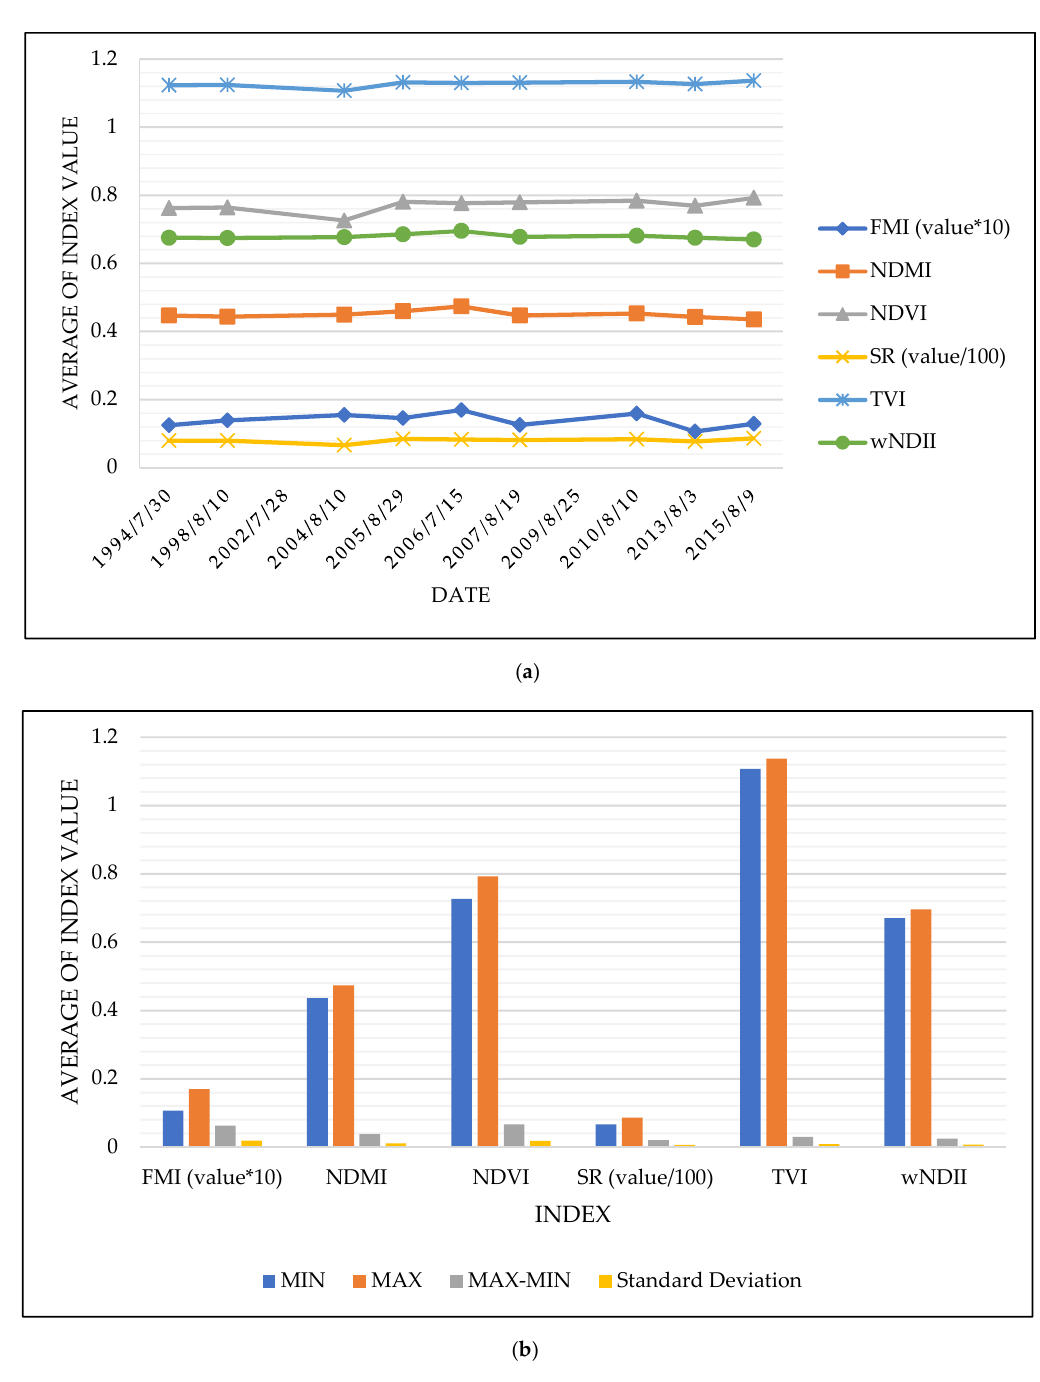
Figure 17. Time series of the vegetation indices for the area affected by the bark beetle and the wind calamity ( a ); and the statistical information ( b ) (the average from the Sumava National Park) (Source: Own work).